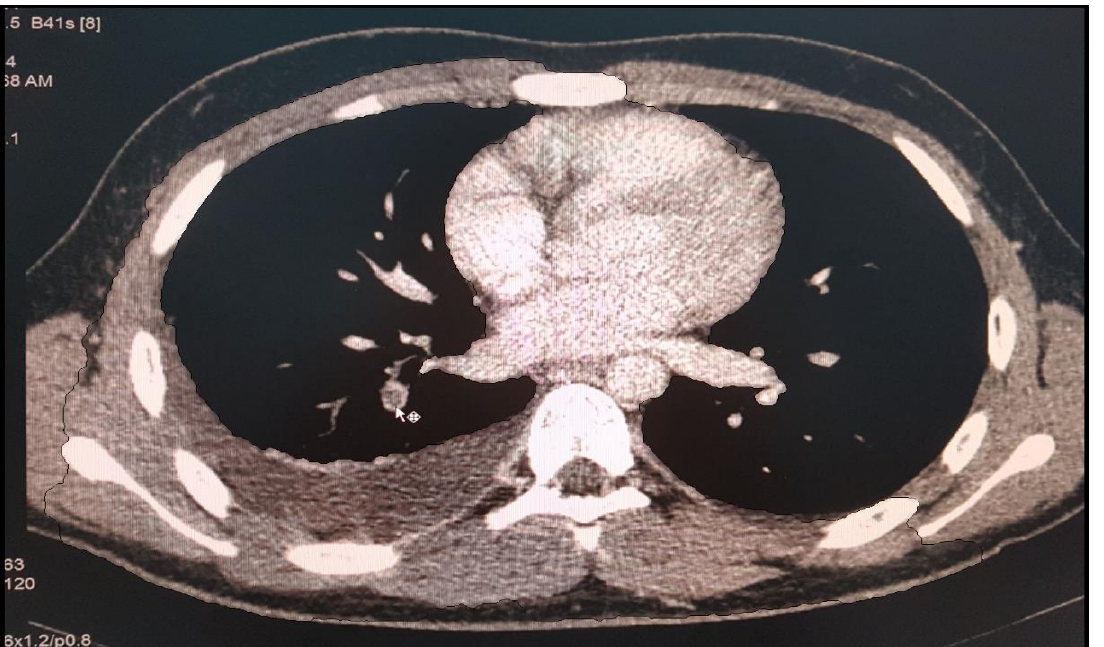
Figure 3. CT scan, appearance of right pulmonary artery segmental branch thrombosis, pulmonary embolism and right secondary pleurisy (personal collection Nephrology Department) . embolism and right secondary pleurisy (personal collection Nephrology